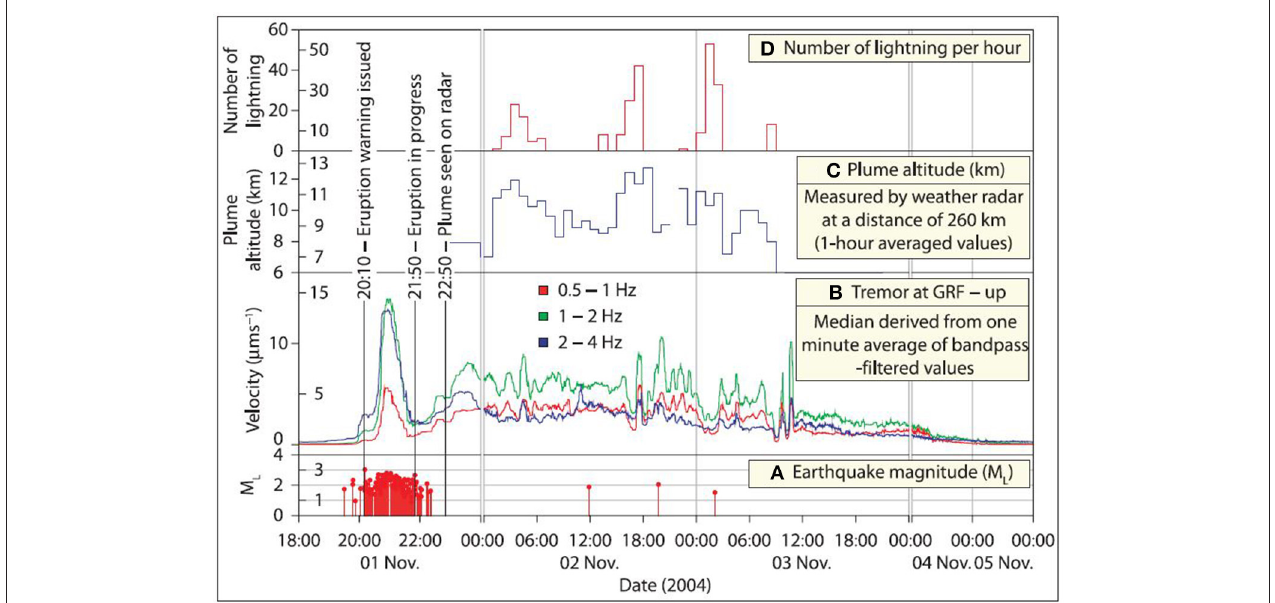
FIGURE 7 | The time line of the Grímsvötn 2004 eruption. From Vogfjörd et al. (2005). Reproduced with the permission of the copyright holder, Kristín Vogfjörð.